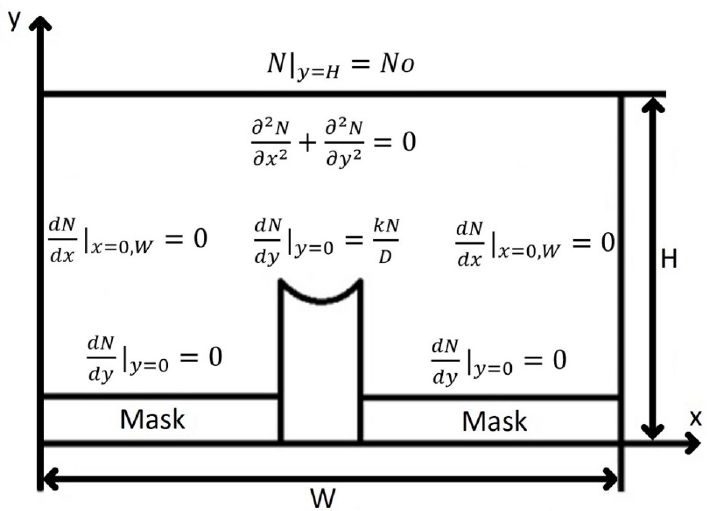
Figure 2. Cross-section of the vapor-phase diffusion simulation domain on a substrate with a window in an oxide mask, where N is a precursor concentration, N 0 is a precursor concentration at the top of the boundary layer, W and H are the width and the thickness of the boundary layer, D is the mass diffusivity constant, and k is the surface reaction constant.